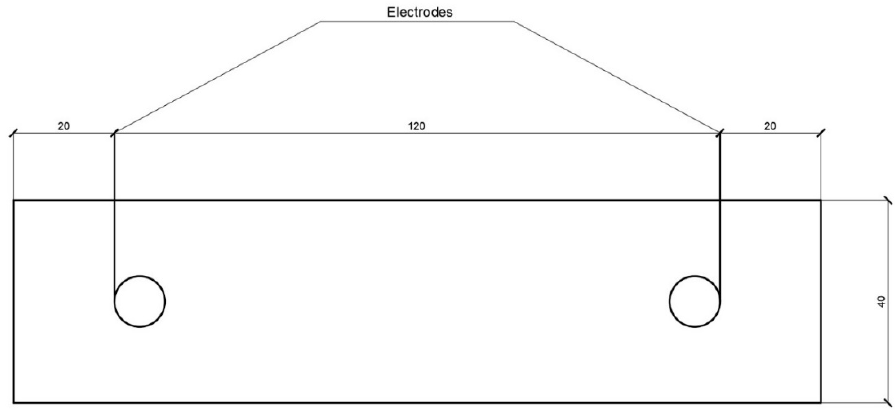
( b ) Figure 3. Changes of electrical characteristics of control sample (CSM) and sample modified with 7% of carbon nanotubes (CNTs): electrical capacity ‐ ( a ), resistance ‐ ( b ).